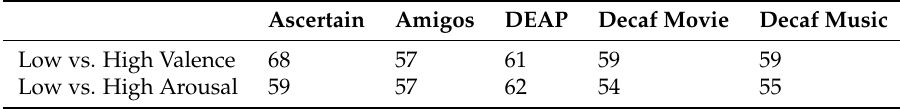
Table 9. F1-scores achieved in the ML experiments from the related